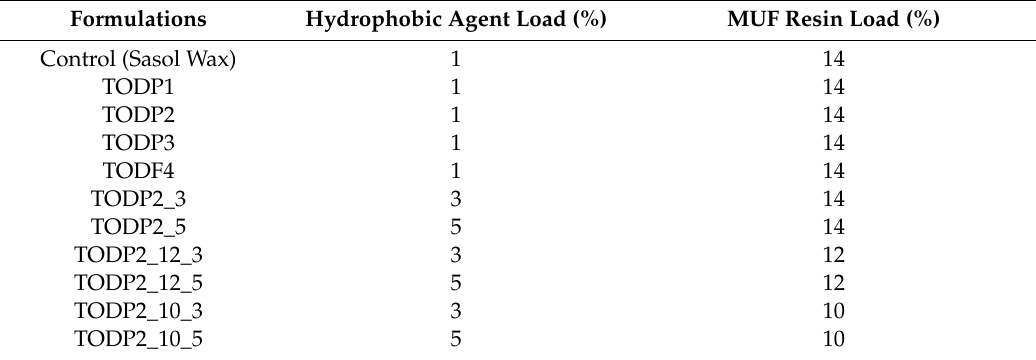
Table 2. Load level of hydrophobic agents and melamine-urea-formaldehyde (MUF) resin for high-density fiberboard (HDF) production.